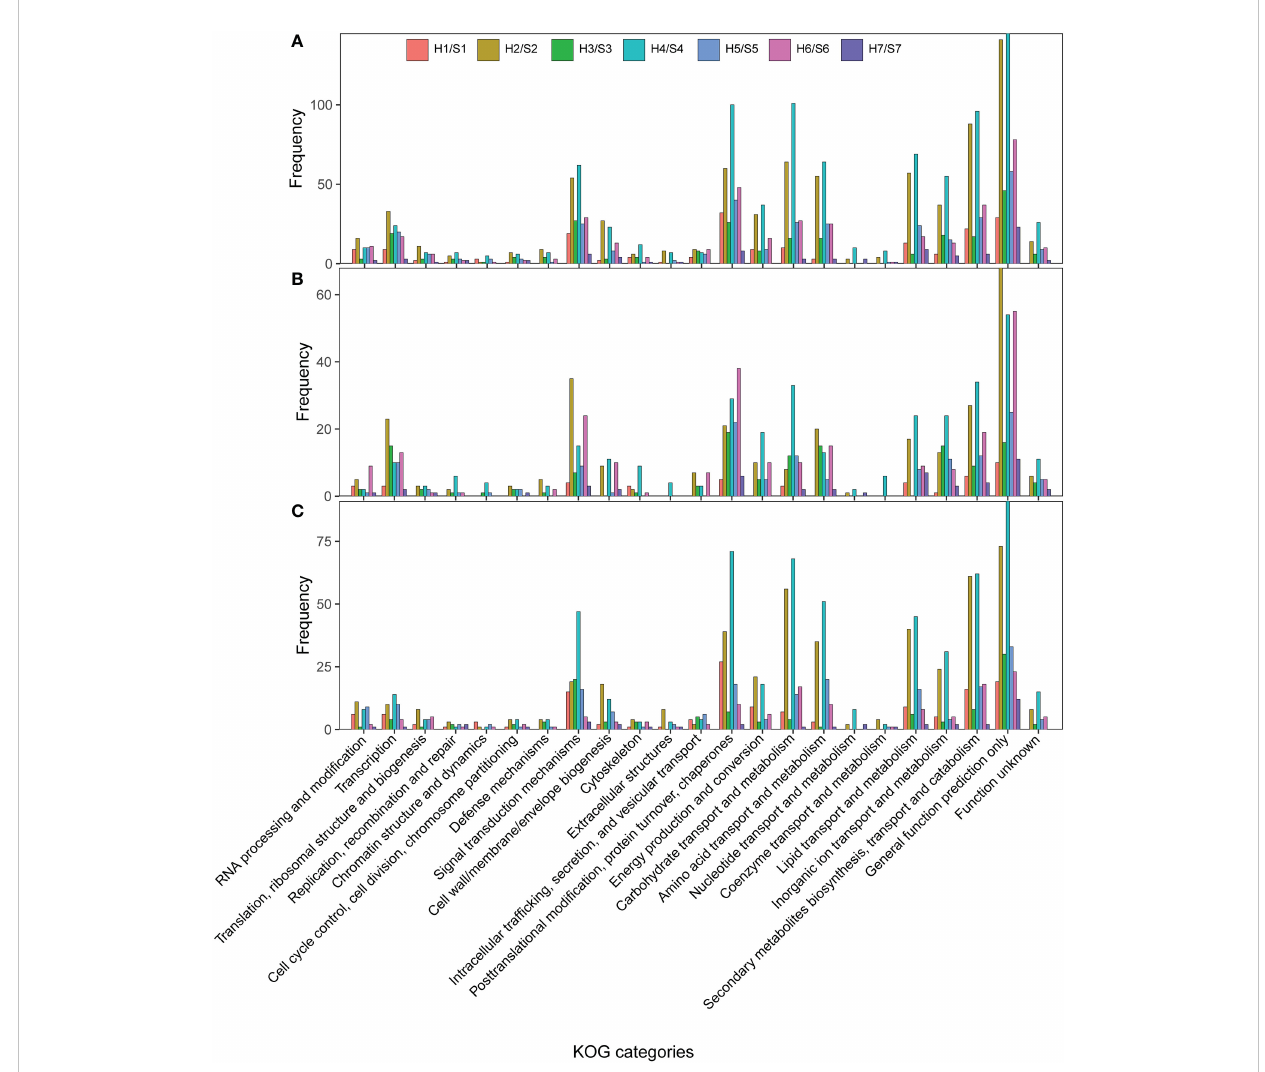
FIGURE 4 KOG categories of DEGs in the different of Sweet potato cultivars under the drought stress. (A) , KOG categories of all DEGs; (B) , KOG categories of up-regulated DEGs; (C) KOG categories of down-regulated DEGs. H1/S1, drought-treated Shangshu-9/control Shangshu-9; H2/S2, drought-treated Chaoshu-1/control Chaoshu-1; H3/S3, drought-treated Xushu-22/control Xushu-22; H4/S4, drought-treated Z15-1/control Z15-1; H5/S5, drought- treated Xushu-18/control Xushu-18; H6/S6, drought-treated Jishu-26/control Jishu-26; H7/S7, drought-treated Xuzi-8/control